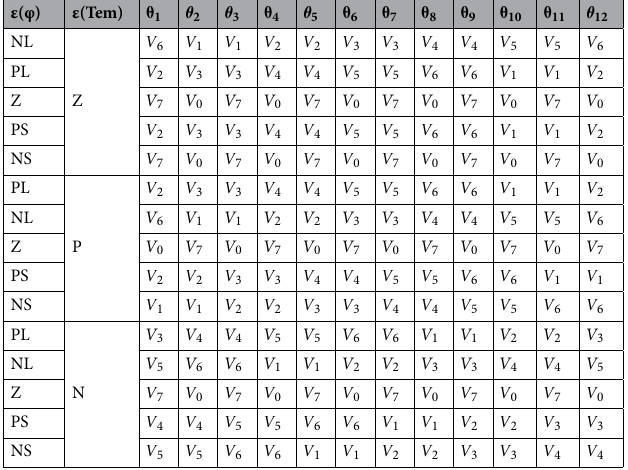
Table 1. Fuzzy switching logic rule base.